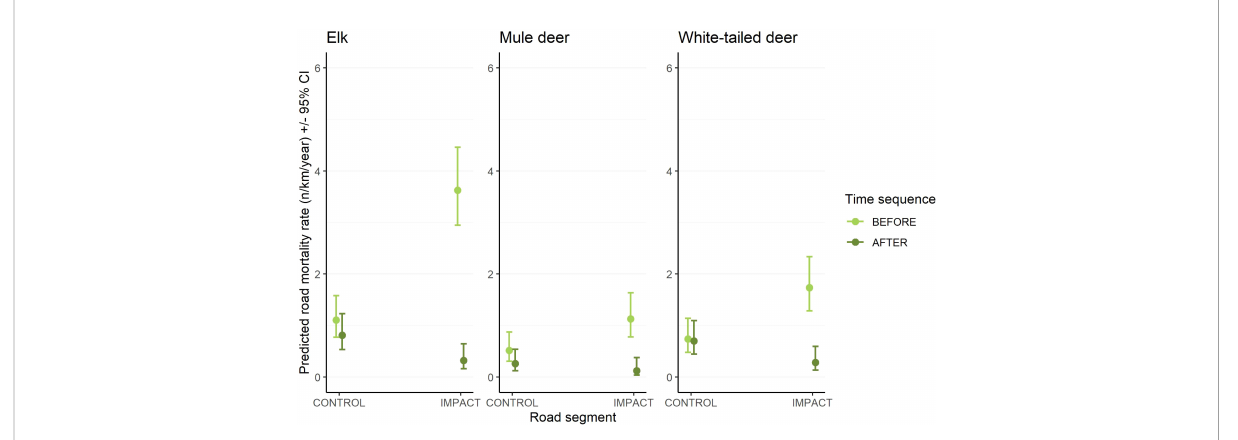
FIGURE 2 Predicted effects of the mixed-effects, Poisson regression showing the interaction between road segment (control vs. impact) and time sequence (before vs. after) on the collision rate of elk (left panel), white-tailed deer (center panel), and mule deer (right panel). For ease of illustration, only the main effects of the model are shown here. The complete statistical model included an AR1 autoregressive term for year nested within study area to account for temporal autocorrelation and a random intercept for the study